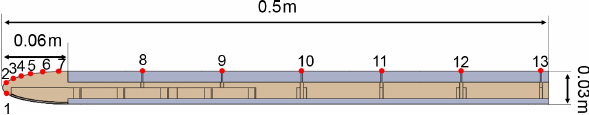
Figure 2. Cross section of the mounted flat plate. Red dots indicate position of pressure sensors. From Jentzsch et al. (2019).